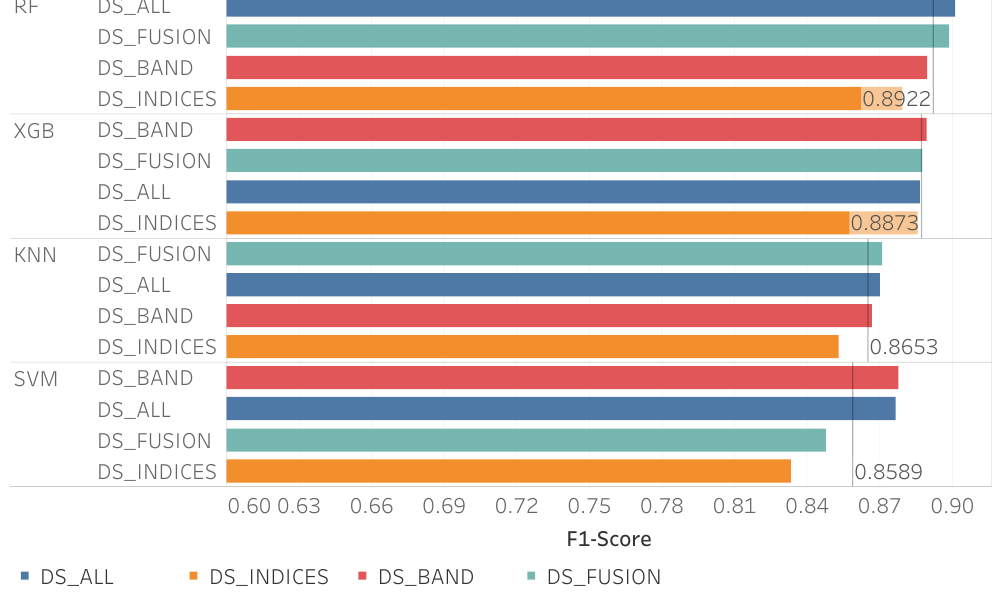
Figure 9. F1-score values of the different algorithms and data sets, for the Fuel Management Zones (FMZs) along